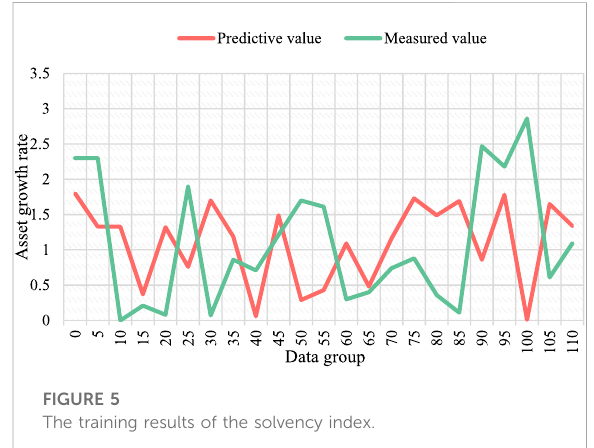
FIGURE 5 The training results of the solvency index.